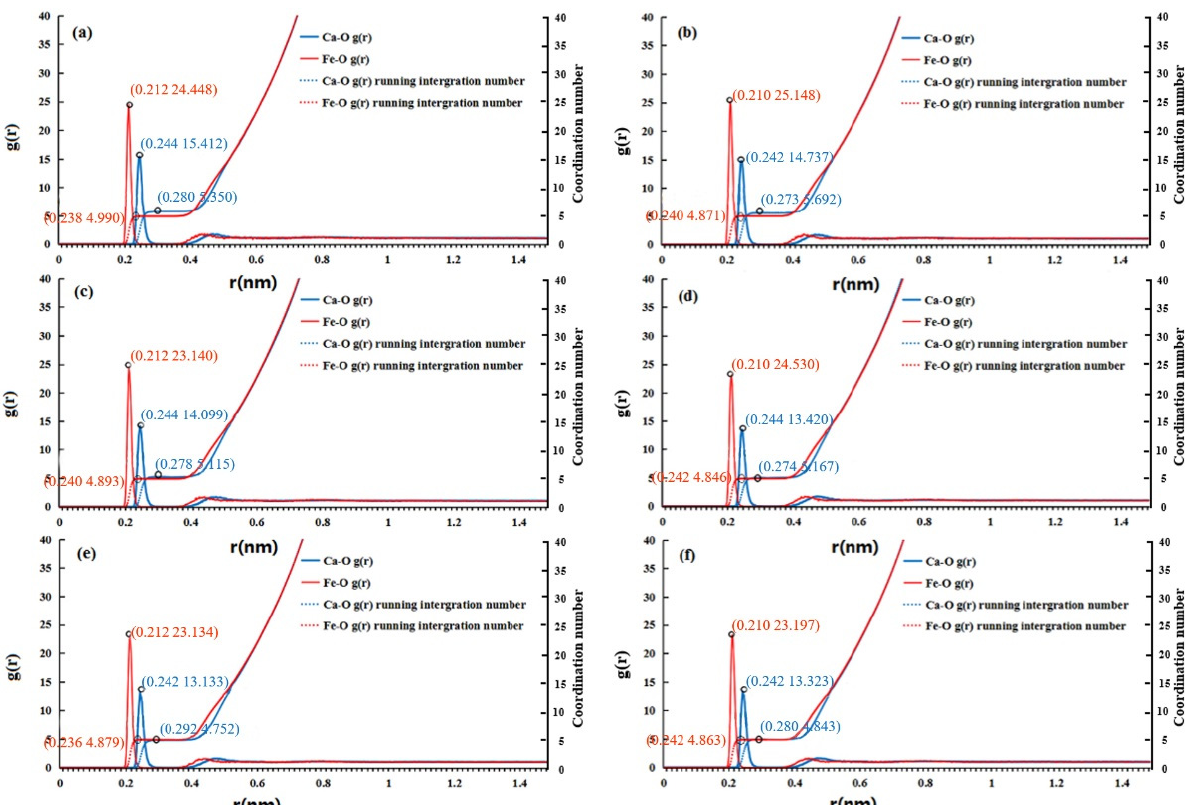
Figure 1. RDFs (curves with one obvious peak) and corresponding running integration numbers (single increment curves) of CaCl 2 solution containing different numbers of Fe 2+ with an electric field applied ( b , d , f ) or without an electric field ( a , c , e ): ( a , b ) 10 Fe 2+ added, ( c , d ) 20 Fe 2+ added, and ( e , f ) 30 Fe 2+ added.